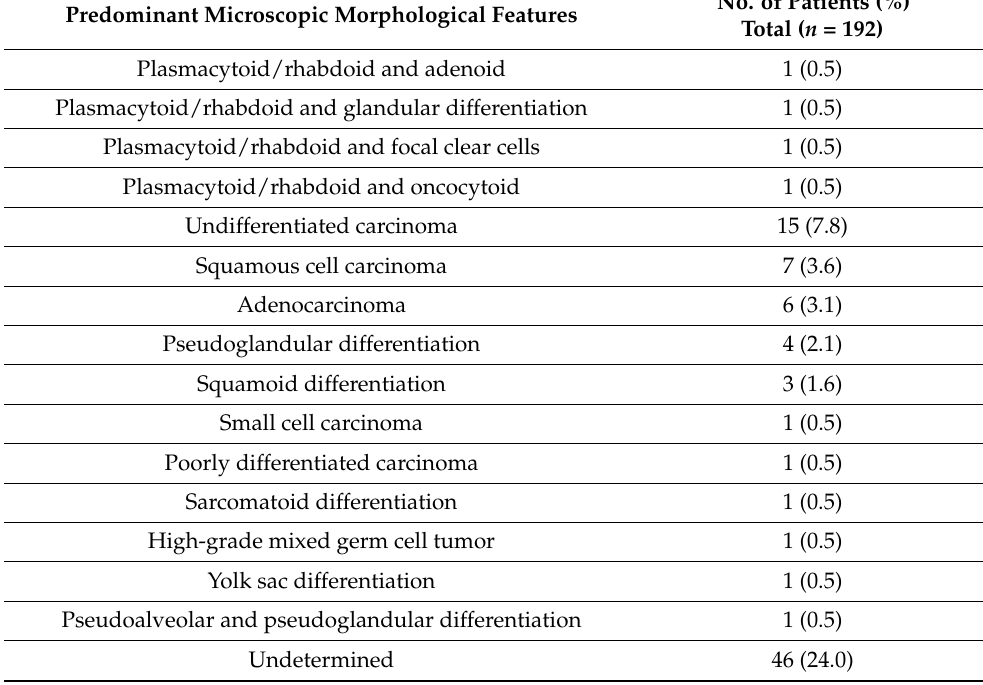
Table 2. Cont. Predominant Microscopic Morphological